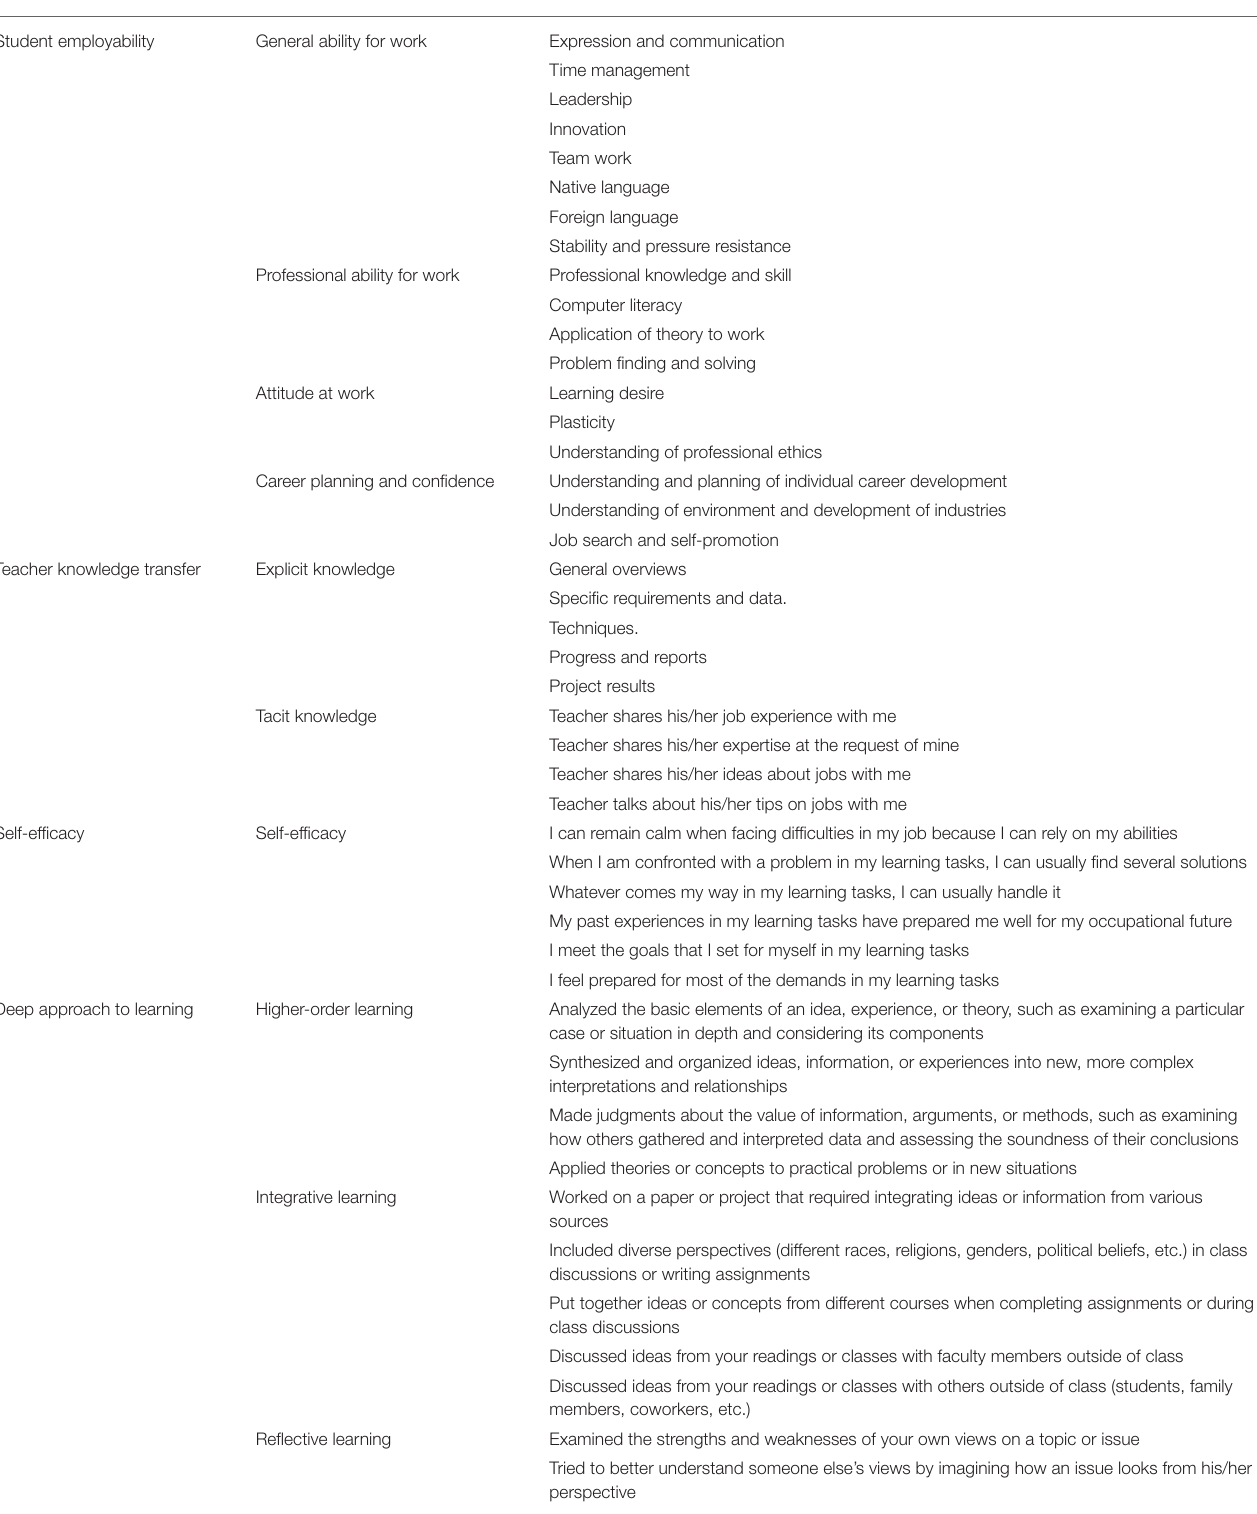
TABLE 2 | Instruments description.